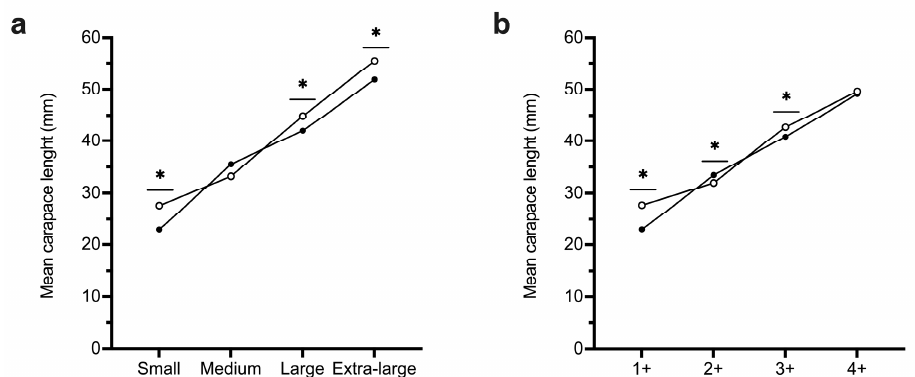
Figure 2. Comparison of the mean carapace length (CL) of A. antennatus females based on commercial categories ( a ) and the groups derived from the modal progression analysis ( b ) in winter (filled circles) and summer (empty circles) for each group present in both campaigns. p < 0.05 obtained from one-way ANOVA and Post-hoc Scheffe test are indicated with an asterisk (*). The MPA from CL-frequency distributions showed that females in both winter and Table 2. Description of the groups identified through the modal progression analysis of the carapace length (CL) frequency distributions of A. antennatus females, including sampling season, modal and age group, mean carapace length with standard deviation (SD), separation index (SI), number of females (N), and estimates of genetic diversity (excluding locus Aa818